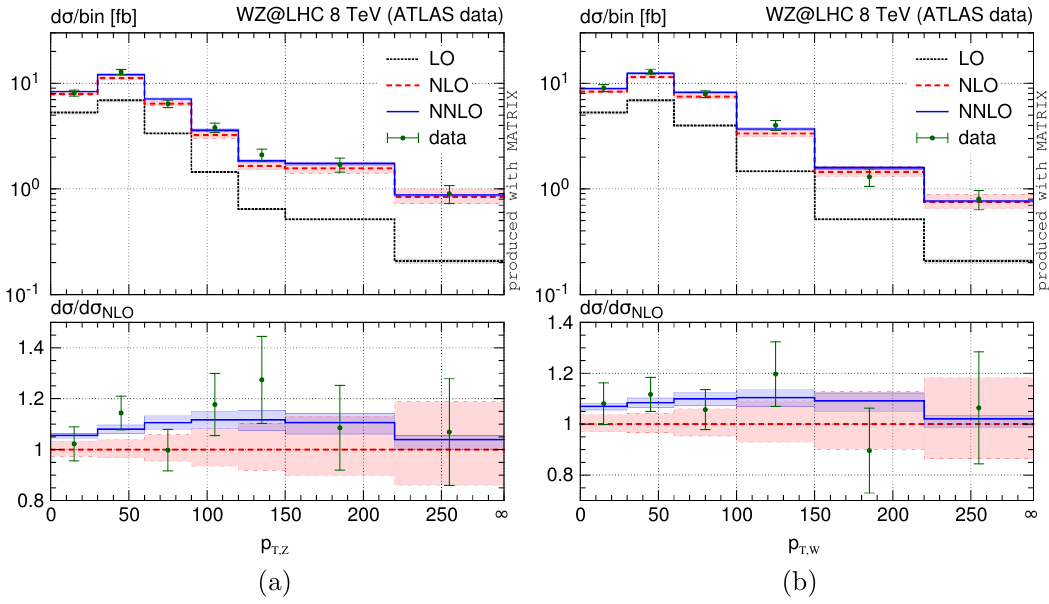
Figure 3 . Distribution in the transverse momentum of the reconstructed (a) Z and (b) W bosons at LO (black, dotted), NLO (red, dashed) and NNLO (blue, solid) compared to the corresponding ATLAS data at 8 TeV (green points with error bars). The lower panel shows the ratio over the NLO